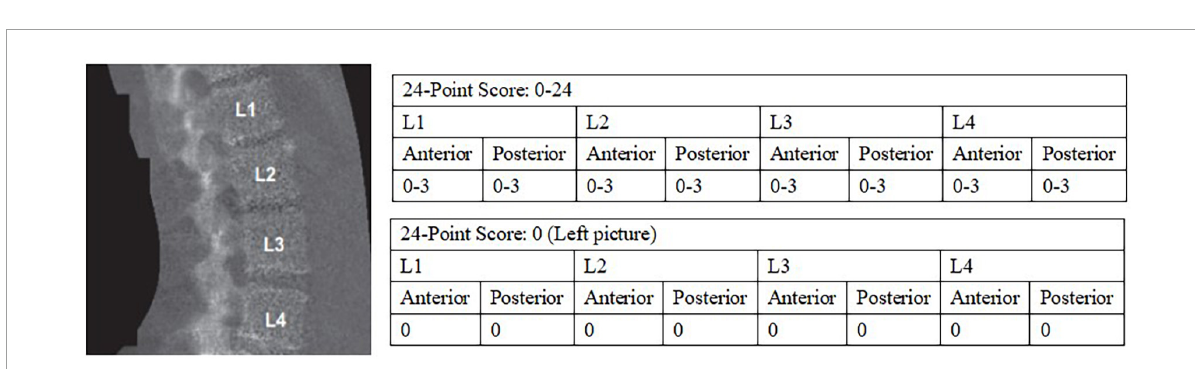
history (yes or no), hypertension (yes or no), diabetes (yes or no), osteoporosis (yes or no), sleep disorder (yes or no), BMI ( < 23 or ≥ 23 kg/m 2 ), SBP ( < 140 or ≥ 140 mmHg), DBP ( < 90 or ≥ 90 mmHg), FPG ( < 126 or ≥ 126